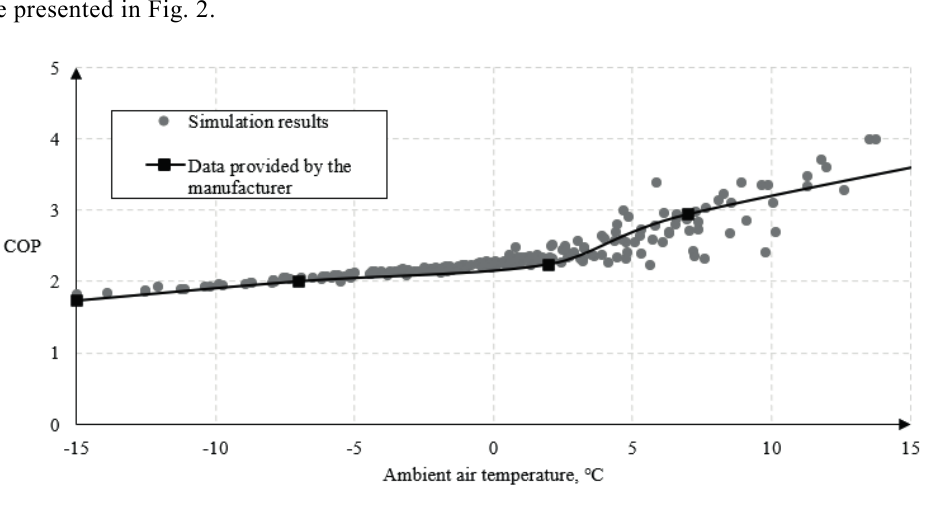
Fig. 2. Comparison of experiment and model